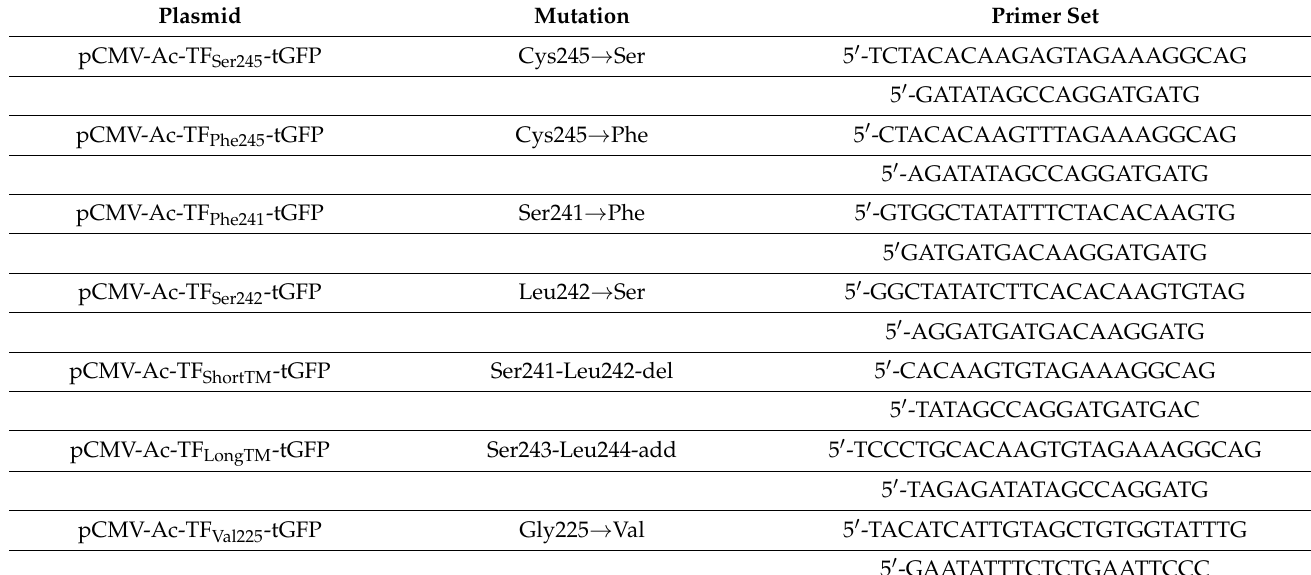
Table 1. The list of TF variants and DNA primers used for mutagenesis. Plasmid Mutation Primer Set pCMV-Ac-TF Ser245 -tGFP Cys245 →